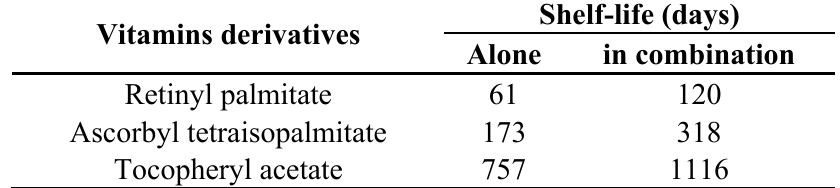
Table 2. Shelf-life of vitamins derivatives A, C and E, when added, alone (in different formulations) or in combination (in the same formulation), stored at 45 and 37 °C, 75%